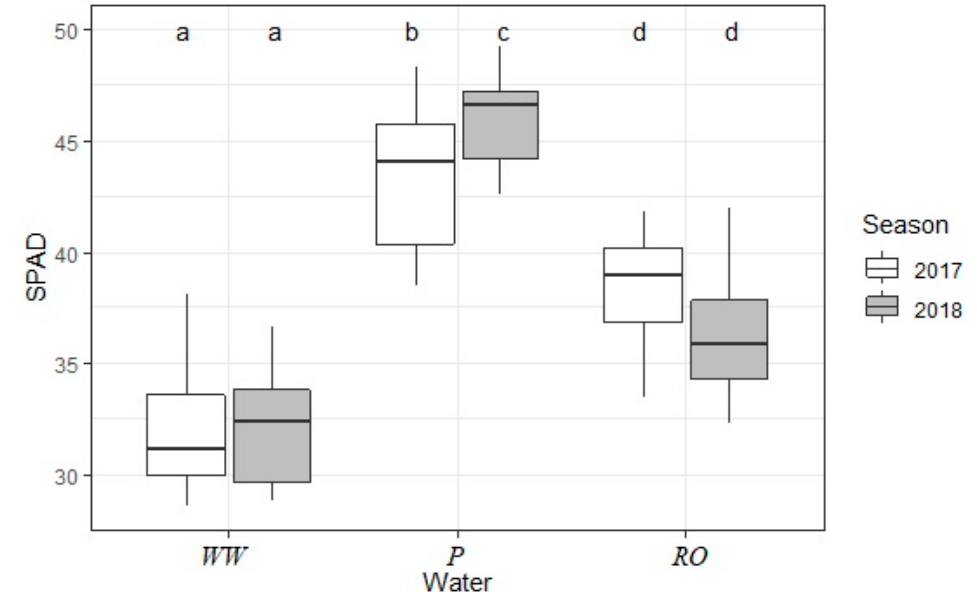
Figure 6. SPAD values in water-season combinations. Letters at the top indicate homogeneous groups by Tukey’s honestly significant difference (HSD) test. The three water supply levels were: unlimited water, WW ; water withdrawn, RO and rainfed, P crops.